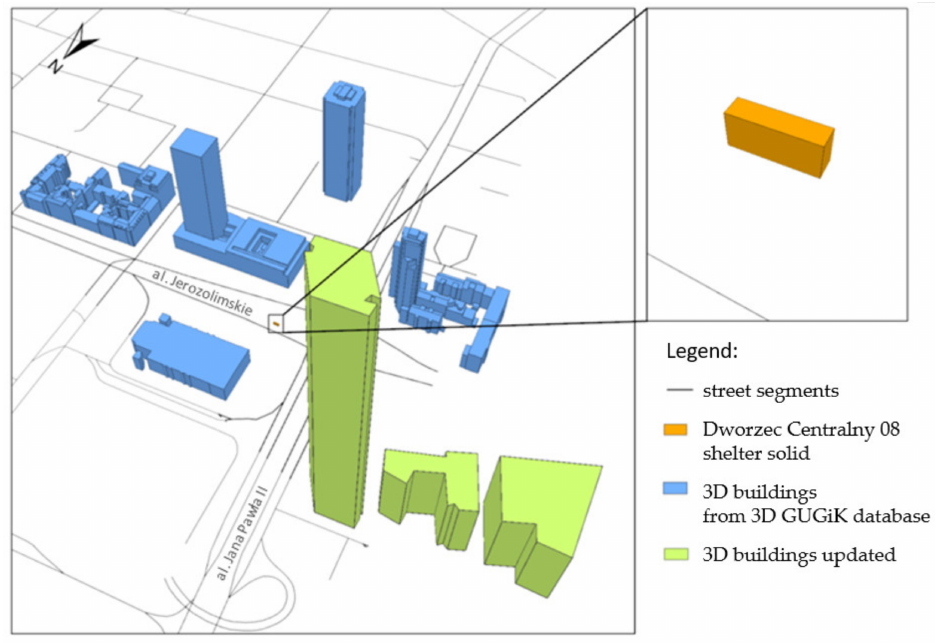
Figure 11. The result of the stage of data preparation for spatial analysis—3D layers for the surround- ings of the Dworzec Centralny 08 tram